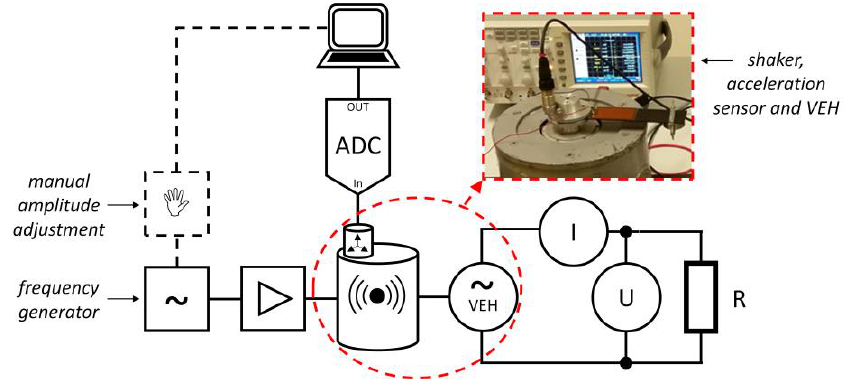
Figure 4. Experimental set-up for the metrological investigation of the piezoelectric Vibration Energy Harvesting (VEH).